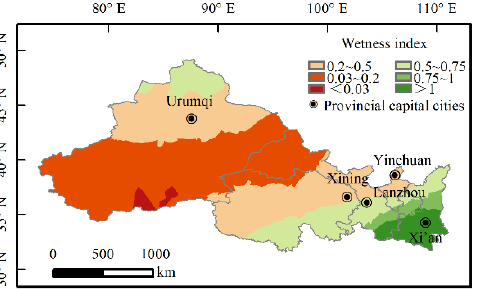
Figure 6. Spatial distribution of interannual trends of humidity index in five provinces of Northwest China from 1960 to 2020.